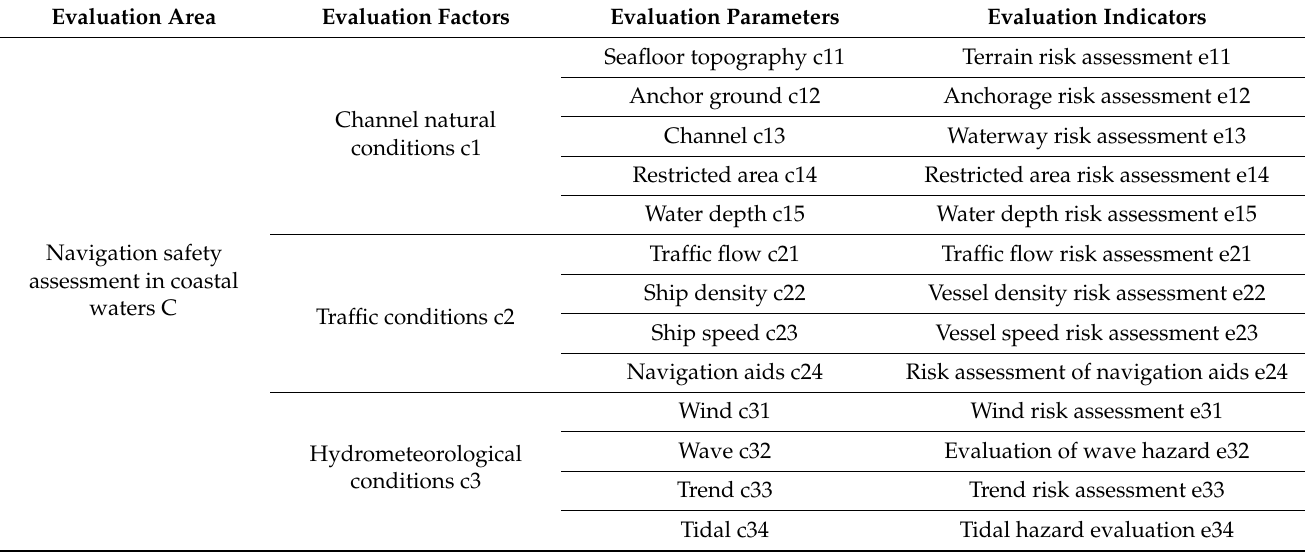
Table 3. Security risk evaluation index